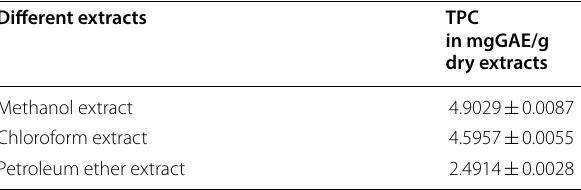
Values are expressed as mean